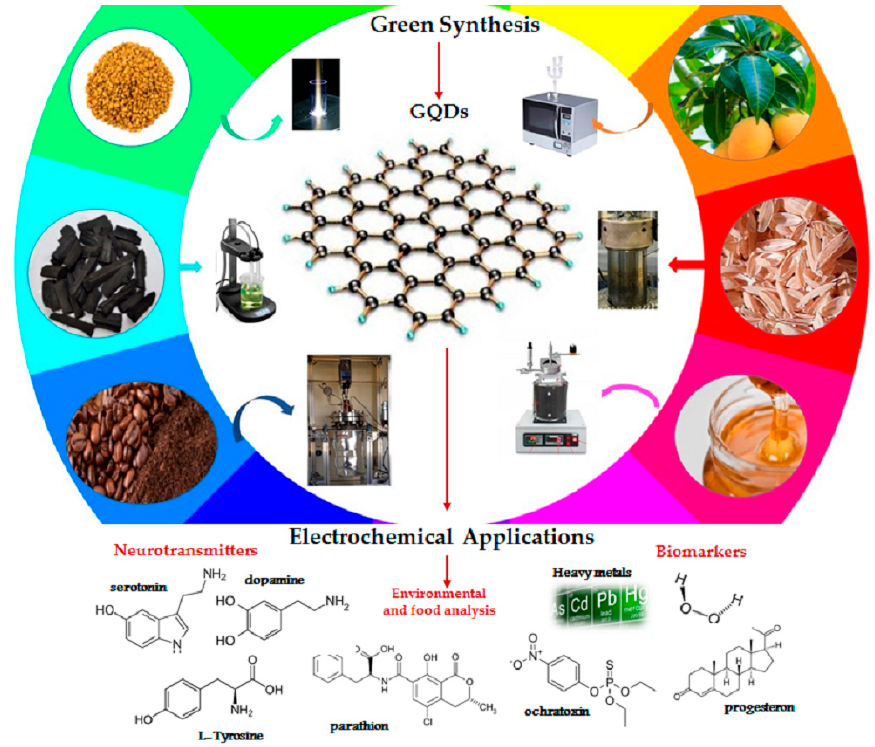
Figure 1. Green synthesis of GQDs and their recent applications in electrochemical sensors.